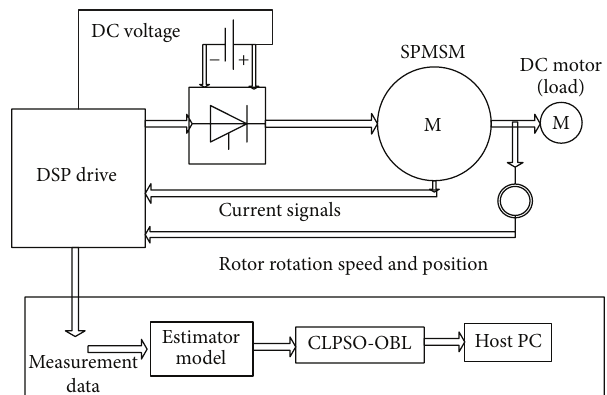
Figure 2: The hardware and software platform for the identification of stator resistance and rotor flux linkage in